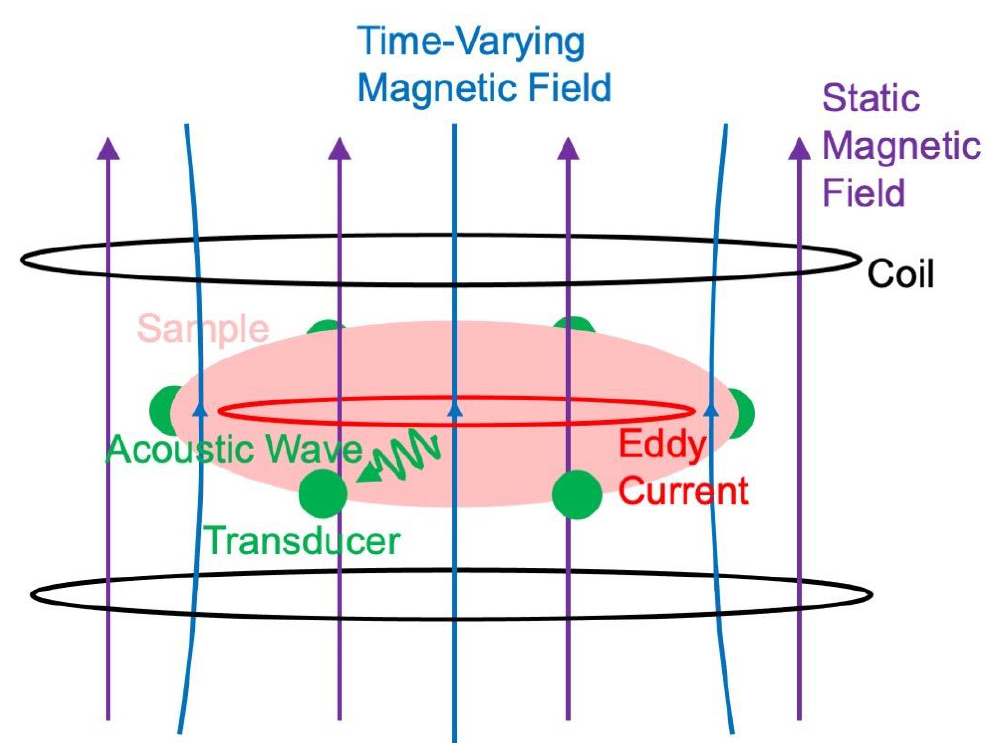
Figure 4. Magneto-acoustic tomography with magnetic induction.